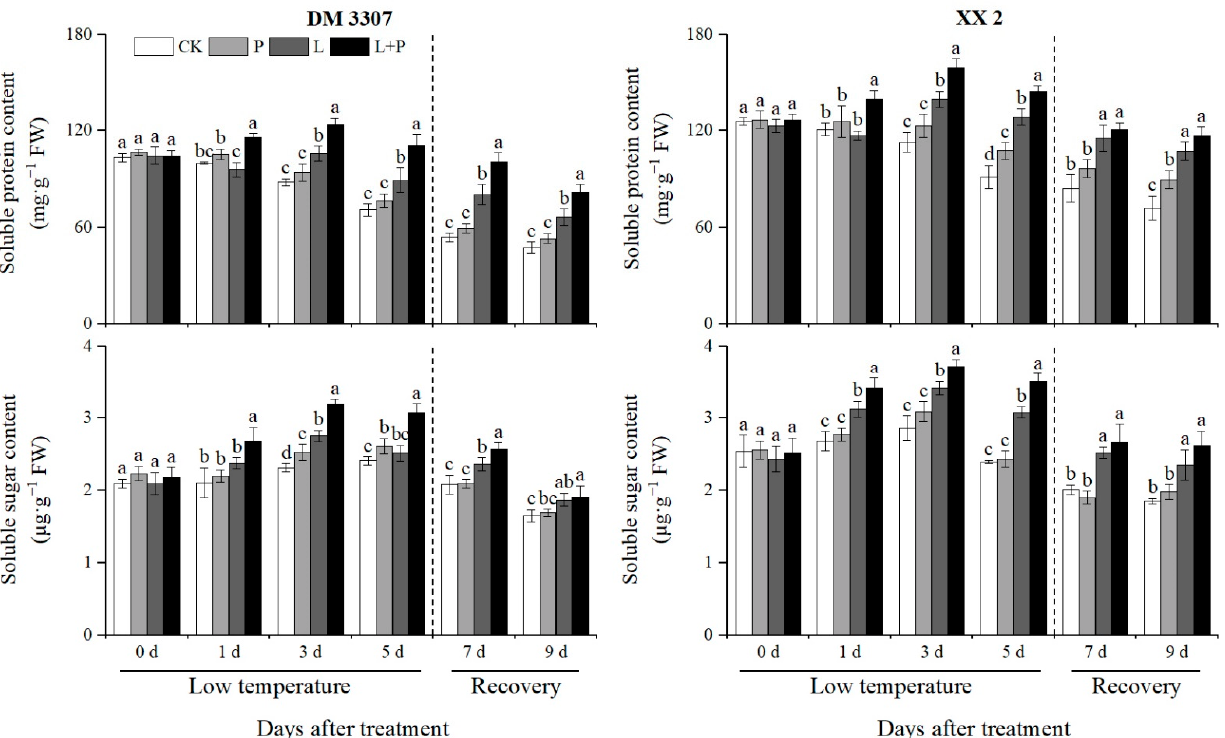
Figure 7. Effect of exogenous proline on the contents of soluble protein and soluble sugar in embryos of maize under the different treatment conditions. Notes: Data are expressed as mean ± standard deviation. Different letters within the same column indicate significant differences at the 5% level.